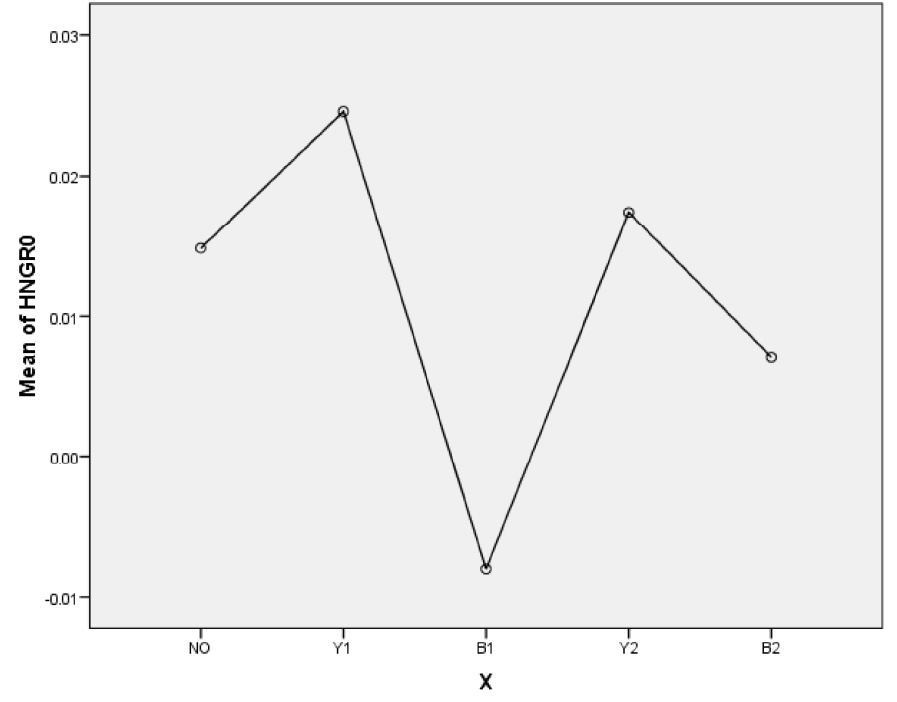
Figure 3. Sample of mean